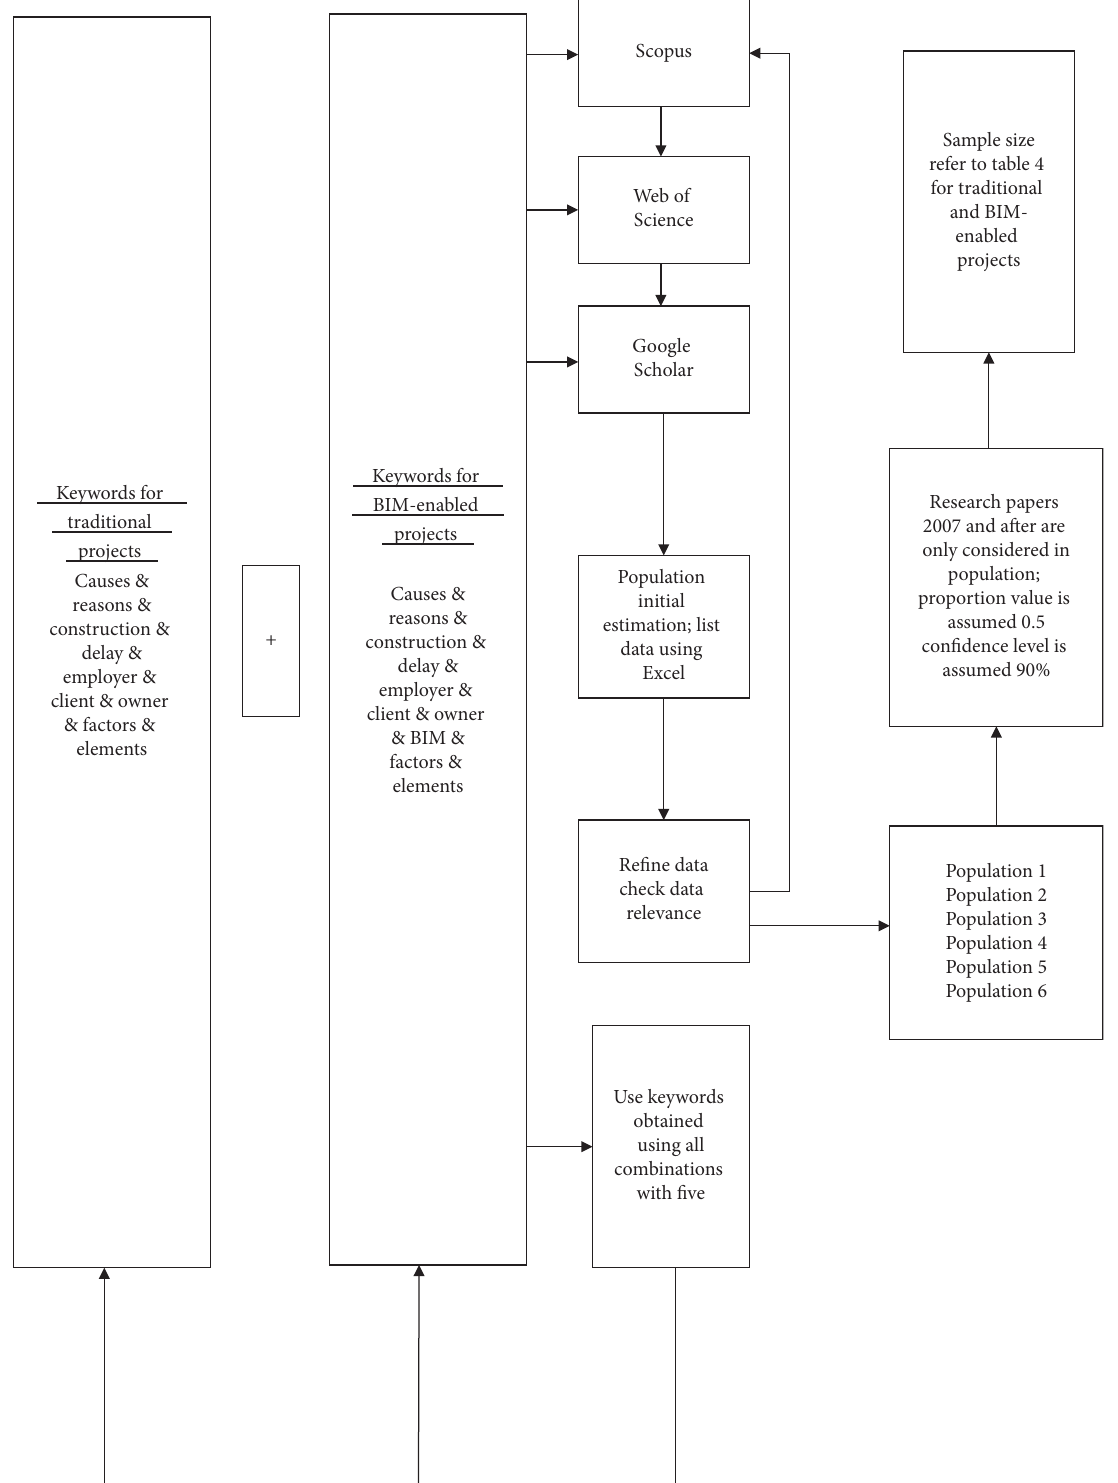
Figure 2: Search methodology to estimate population/sample size for target research